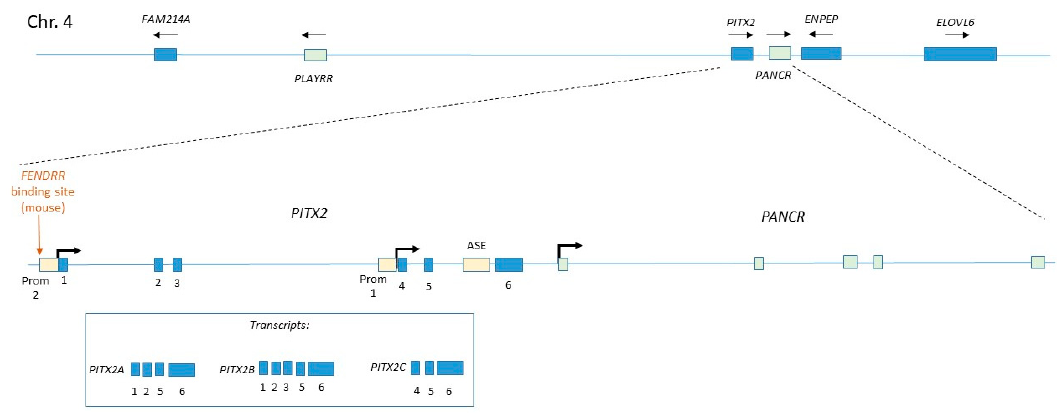
Figure 3. Organisation of the PITX2 / PANCR ( PITX2 adjacent noncoding RNA) / PLAYRR ( PITX2 locus-asymmetric regulated RNA) locus. Blue boxes indicate protein-coding exons / genes, green boxes indicate transcribed non-coding loci and yellow boxes indicate regulatory regions of DNA. The location of the mouse Fendrr binding site is indicated. The lower box illustrates the three transcripts produced from the PITX2 locus.